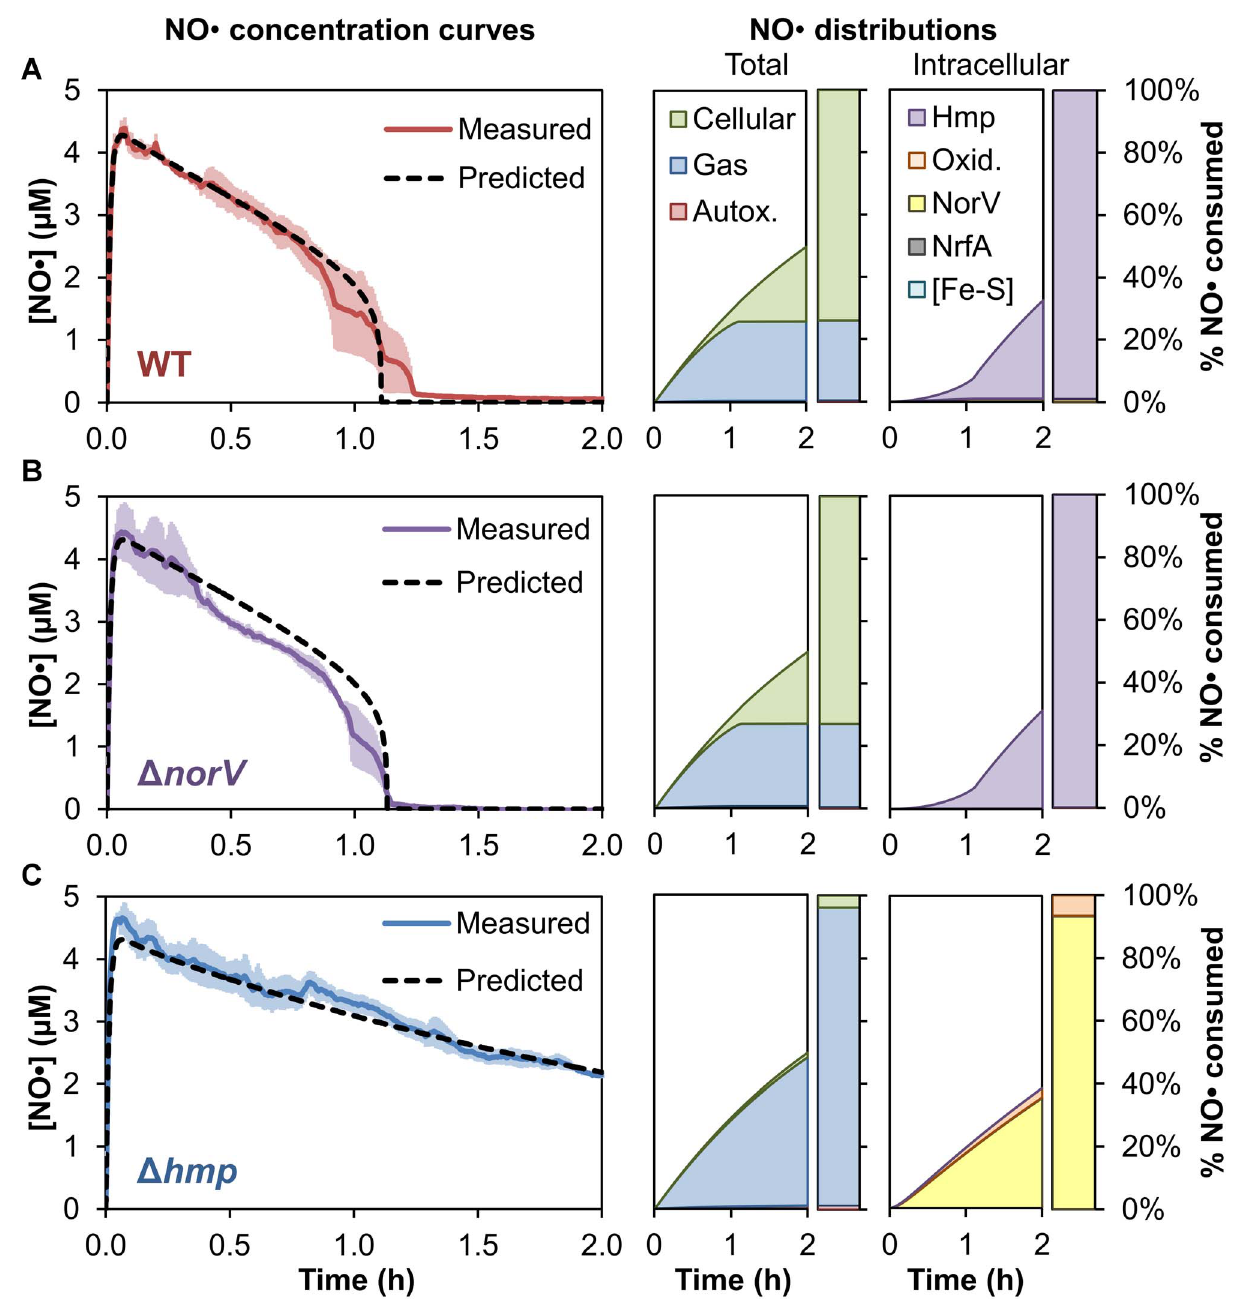
Figure 7. NO N dynamics and distribution in E.coli cultures under microaerobic conditions. Shown along the left are the simulated and experimentally-measured NO N concentration profiles for (A) wild-type, (B) D norV , and (C) D hmp cultures following addition of 0.5 mM DPTA, where the O 2 concentration was maintained at 35 m M by bubbling with N 2 . Error bars (light red, light purple, and light blue for wild-type, D norV , and D hmp , respectively) represent the standard error of the mean for at least 3 independent experiments. Shown directly to the right of the NO N concentration profiles are the corresponding predicted cumulative distributions of total (left) and intracellular (right) NO N consumption. dependency of Hmp utility on the NO N delivery rate, and (2) NO N and recovery from bacteriostasis was far more similar discover that Hmp is the dominant cellular NO N detoxification between wild-type and D hmp E. coli than with a slower NO N system at dissolved O 2 concentrations as low as 35 m M donor (DPTA). This effect arises from substrate inhibition of (microaerobic). Both of these predictions were validated the Hmp active site caused by high NO N /O 2 concentration experimentally, thereby demonstrating the utility of the model ratios and the time required to synthesize Hmp [23]. An effect for the study of NO N metabolism. Specifically, when treated of NO N delivery on its toxicity has been observed previously in with a fast-releasing NO N donor (PAPA), the consumption of a mammalian system [39,40], where it was shown that killing